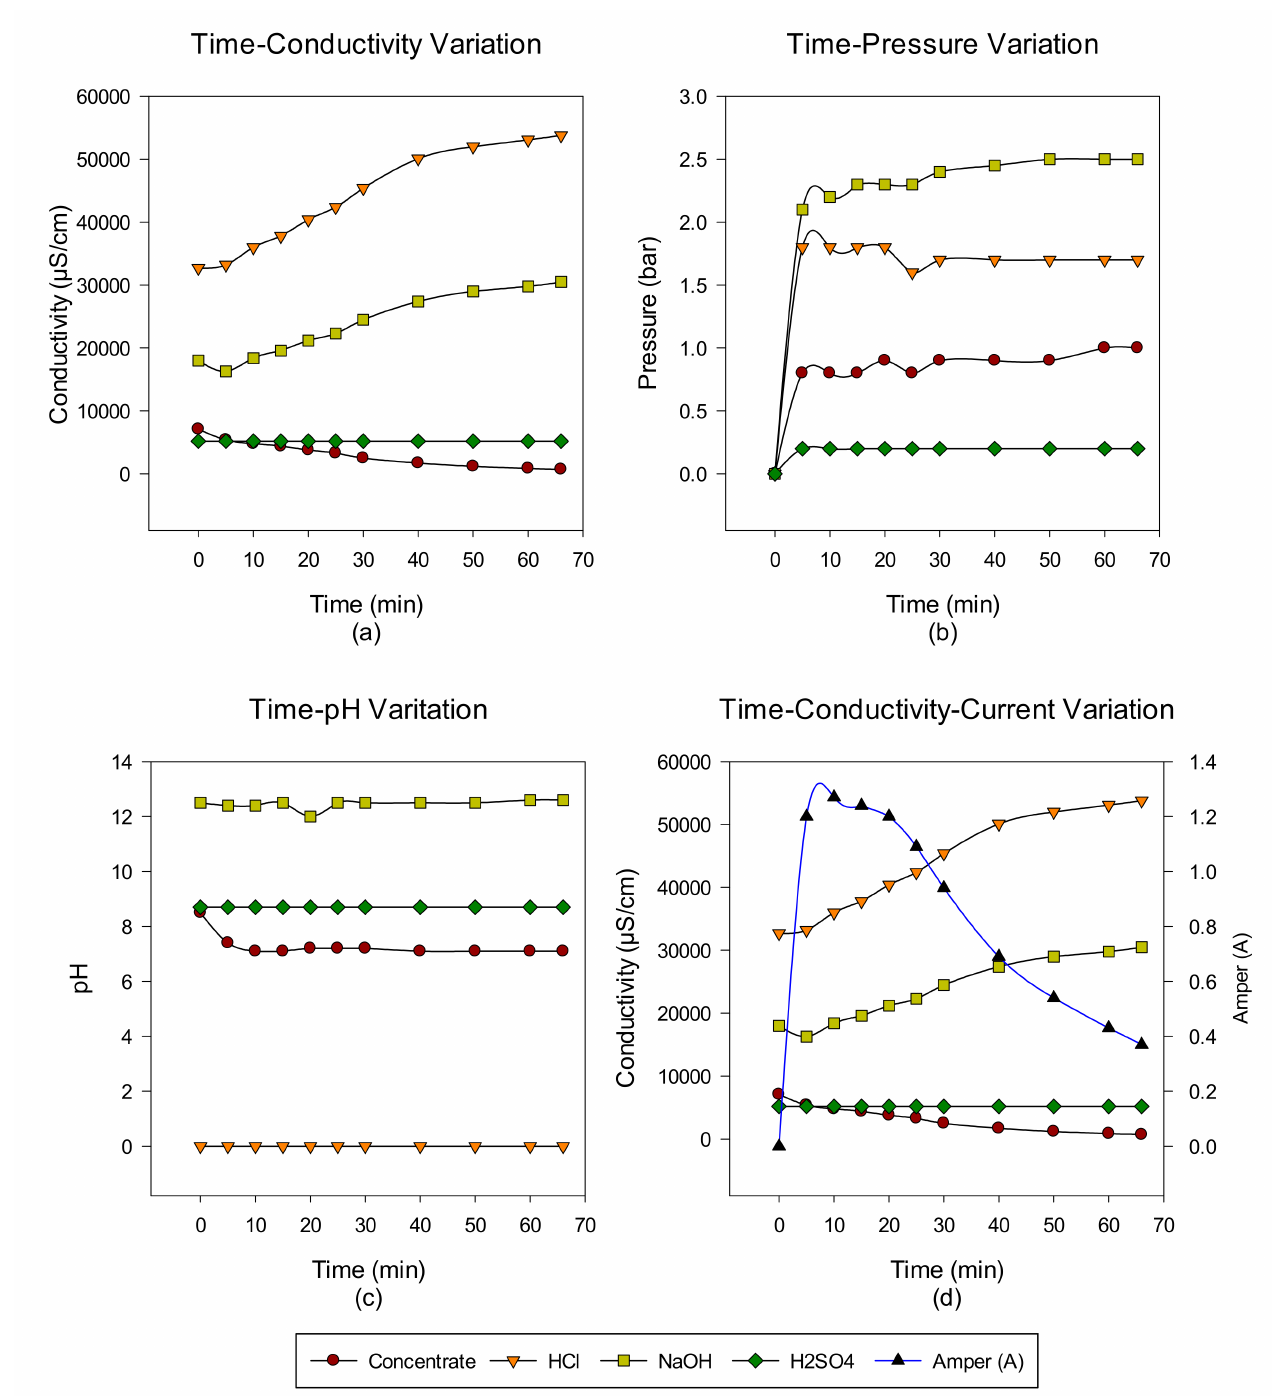
Figure 5. NaCl–NaOH–HCl–Na 2 SO 4 ( a ) conductivity, ( b ) pressure, ( c ) pH, and ( d ) conductivity and ampere change between 0 and 66